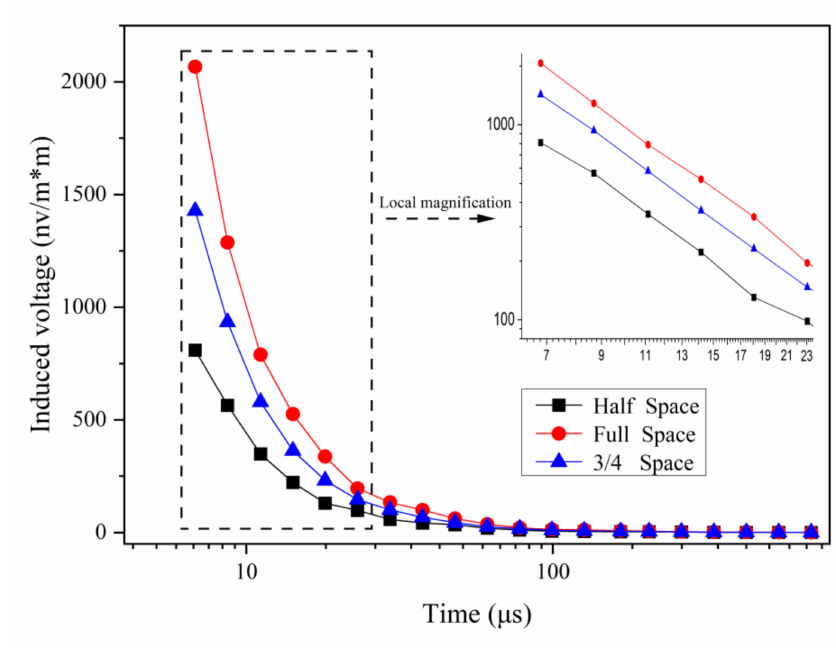
Figure 14. Response curve of saline model experiments under different space